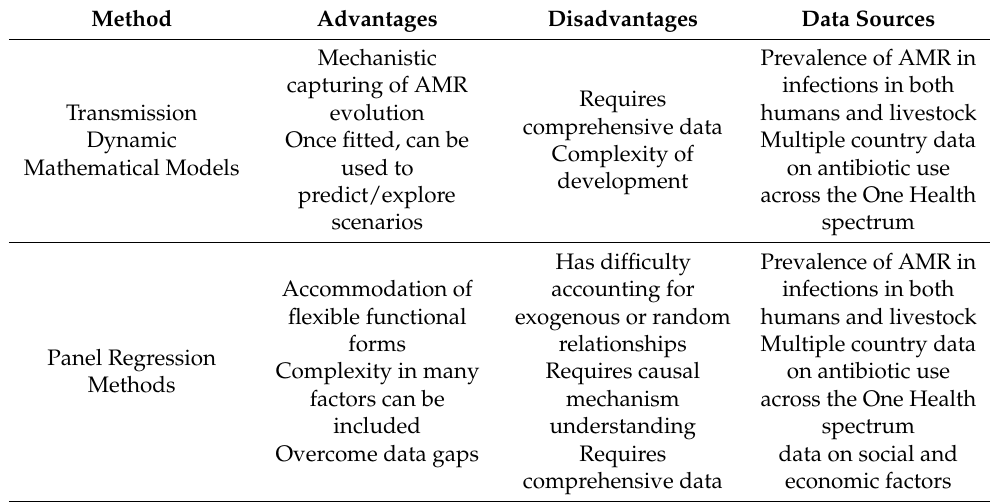
Table 1. Advantages, disadvantages, and data requirements for different methods of estimating the relationship between animal AMU and human